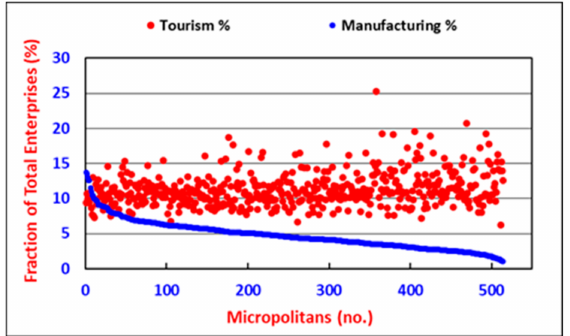
Figure 13. Tourism strengths (% of total enterprises) of the micropolitans, compared with ranked manufacturing sector strengths (% of total